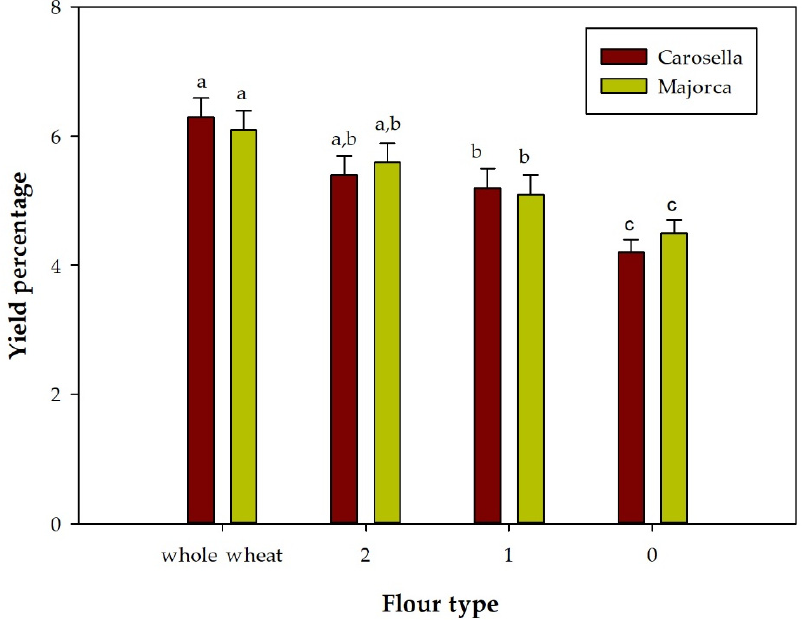
Figure 1. Percentage yields of alcoholic extracts obtained from Carosella and Majorca samples. Different letters indicate statistically significant differences (Bonferroni post hoc test, p <